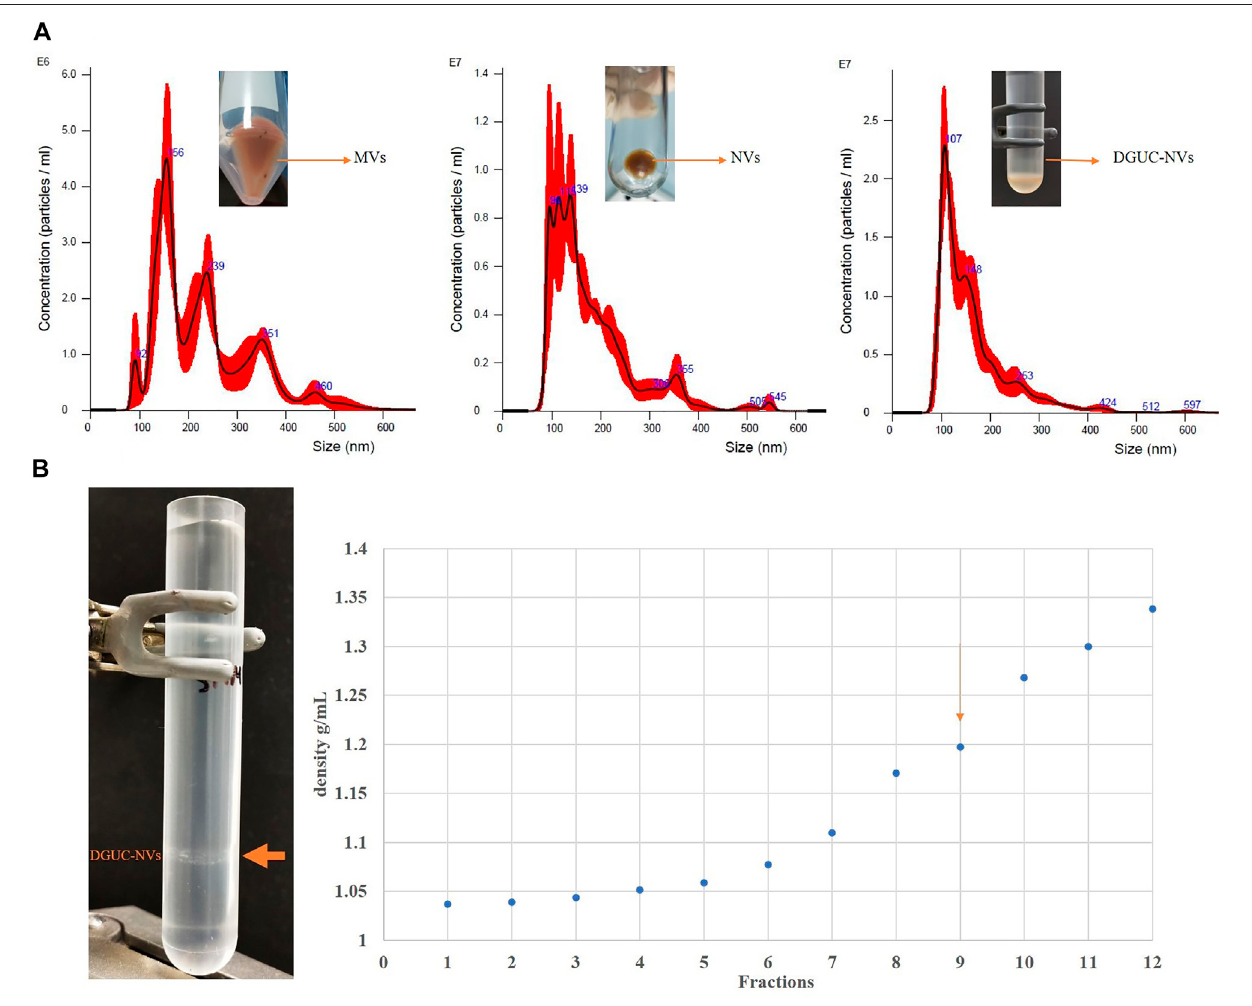
FIGURE 1 | (A) Nanoparticle tracking analysis showing the size distribution of microvesicles (MVs), nanovesicles (NVs), and the sucrose density gradient puri fi ed nanovesicle fraction (DGUC-NVs). Particle numbers, mean diameter values, and standard deviations are reported in Table 1 . (B) The pictures on the left show the sample of strawberry-derived NVs after iodixanol density gradient ultracentrifugation (DGUC). After DGUC, a single visible band could be observed (orange arrow). The densities measured in the 12 different fractions from top to bottom are shown in the chart on the right. The visible band was observed in fraction 9. The vesicles fl oating in fraction nine are similar in density to mammalian extracellular vesicles, which have a density of 1.13 – 1.19 g/ ml (Konoshenko et al., 2018).